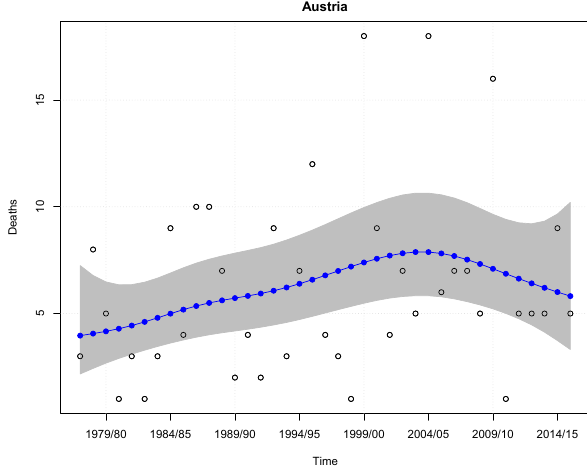
) annual off-piste avalanche •